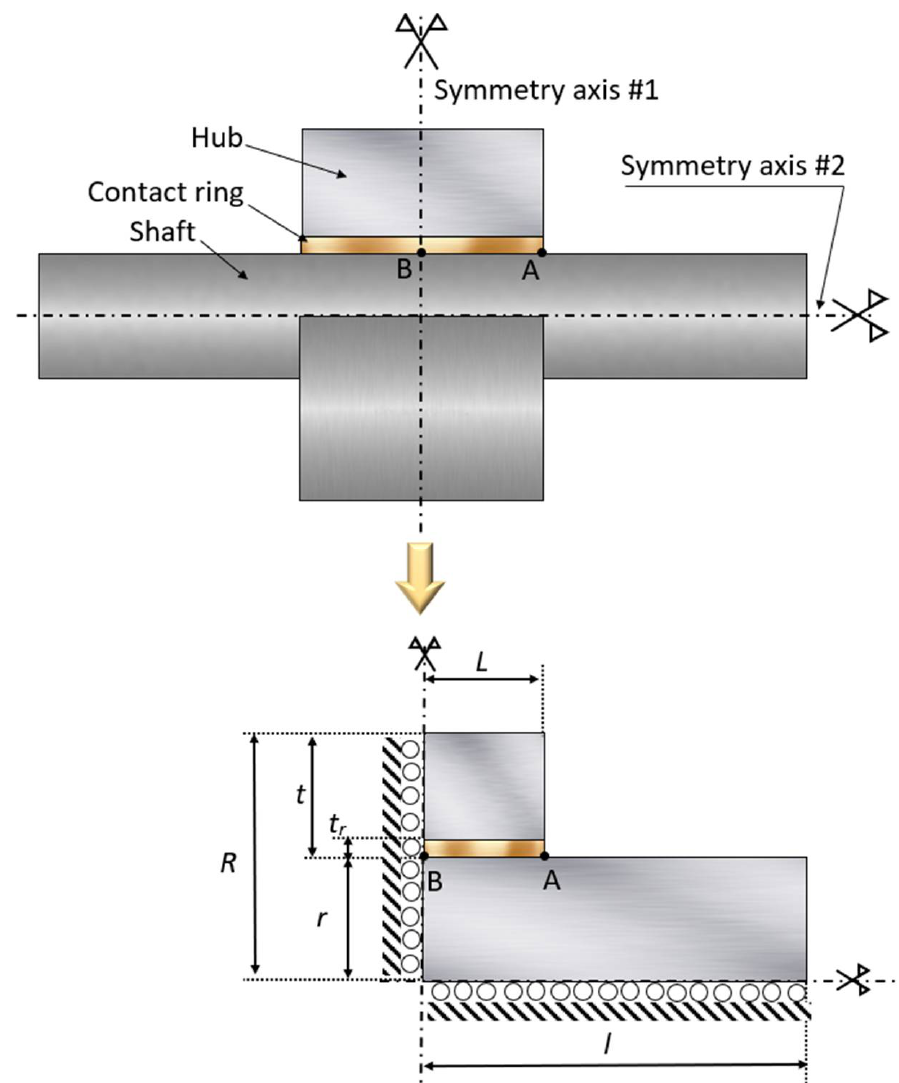
Figure 2. Scheme of the simplified geometry and boundary conditions applied in FEM simula- tions.